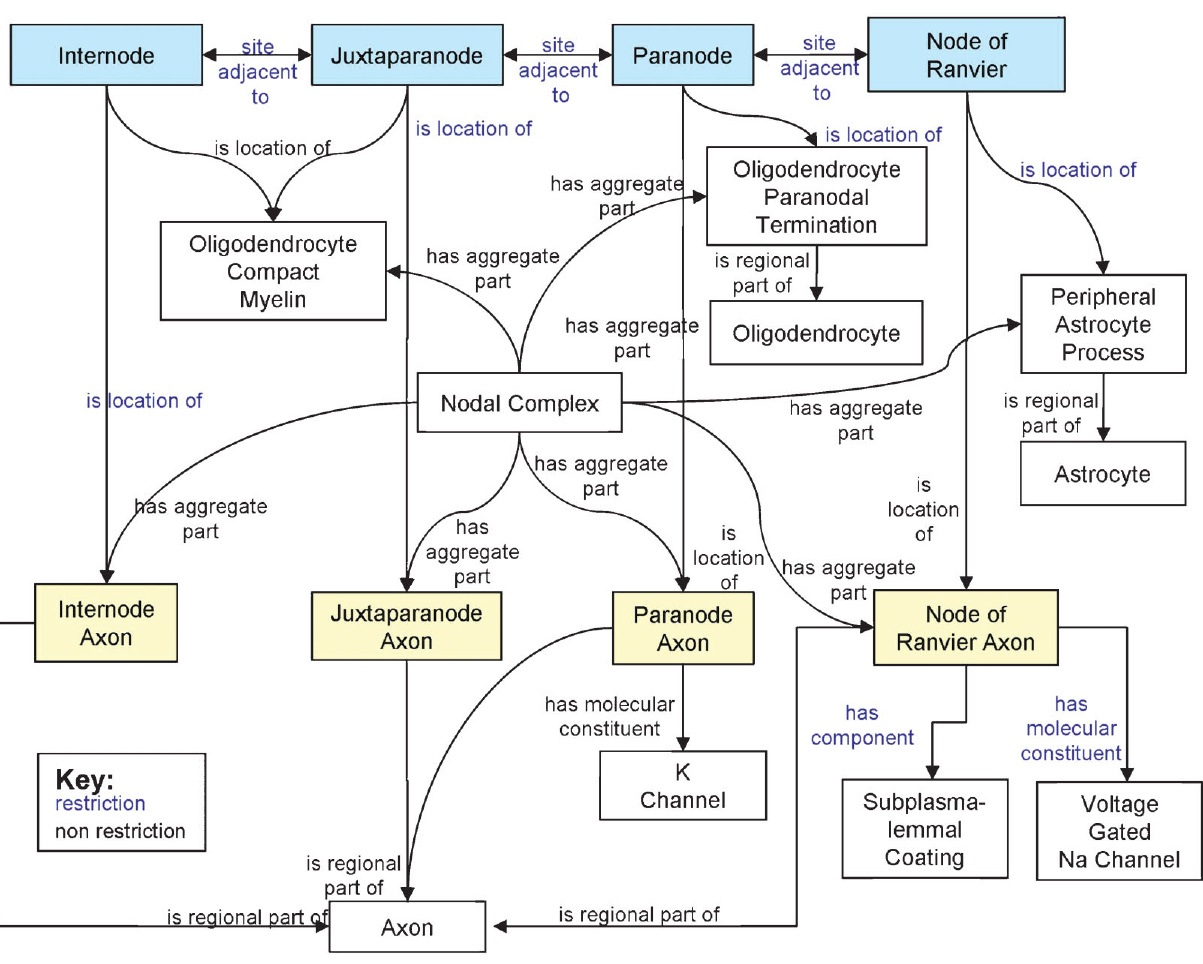
Figure 3. Diagram of a Node of Ranvier instance description in the SAO . The boxes indicate instances of classes that are related to one another as a description of a particular instance of a Node of Ranvier. The blue text indicates relationships that are enforced between classes through the use of OWL restrictions, while the black text indicates relationships defined for this instance